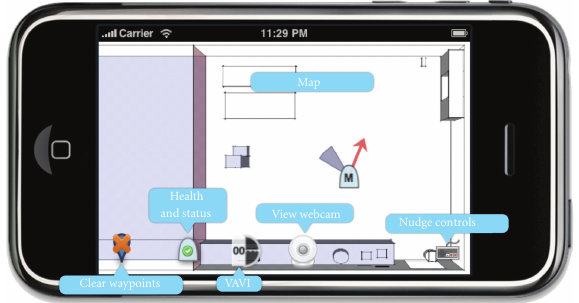
Figure 3: Overview of nudge control interface.